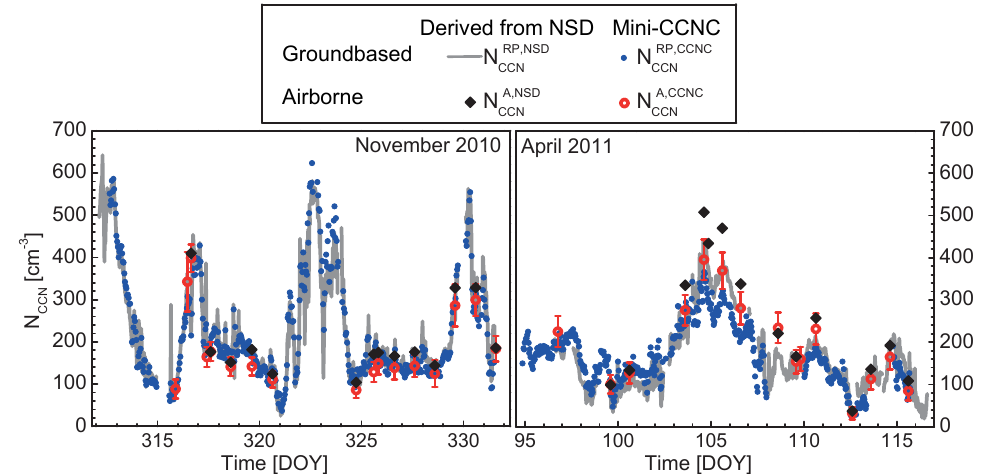
Figure 4. Time series of N CCN measured with the mini-CCNC at a supersaturation of 0.26% both on the ground and in the air and determined from NSDs for a cutoff diameter of 68nm, corresponding to a κ of 0.66 at 0.26% supersaturation.